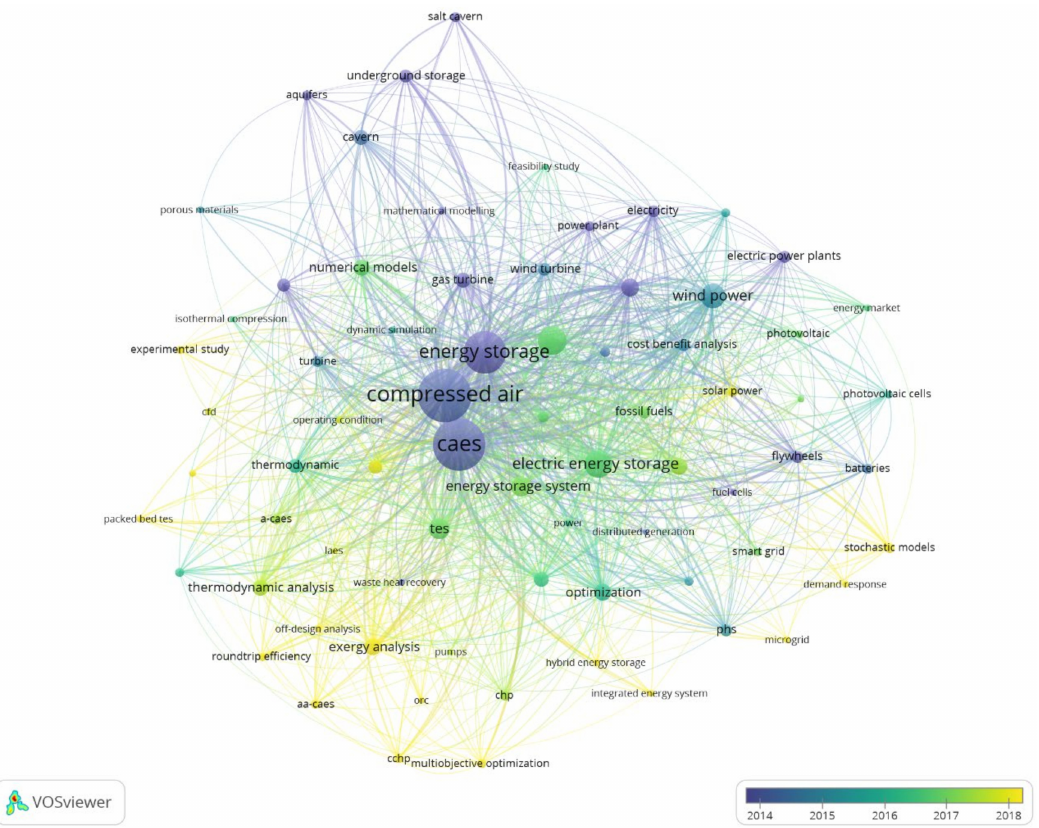
Figure 10. Overlay visualization of keywords related to publications on